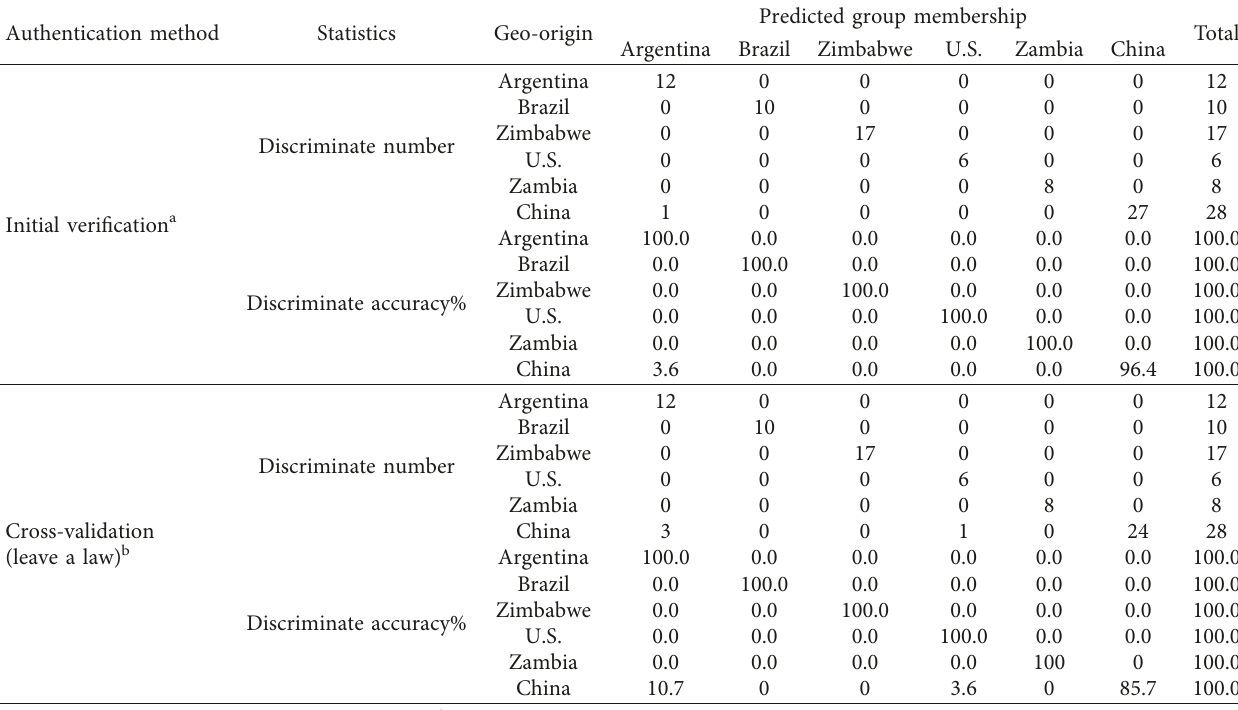
Table 4: The validation of fisher’s linear discrimination functions.